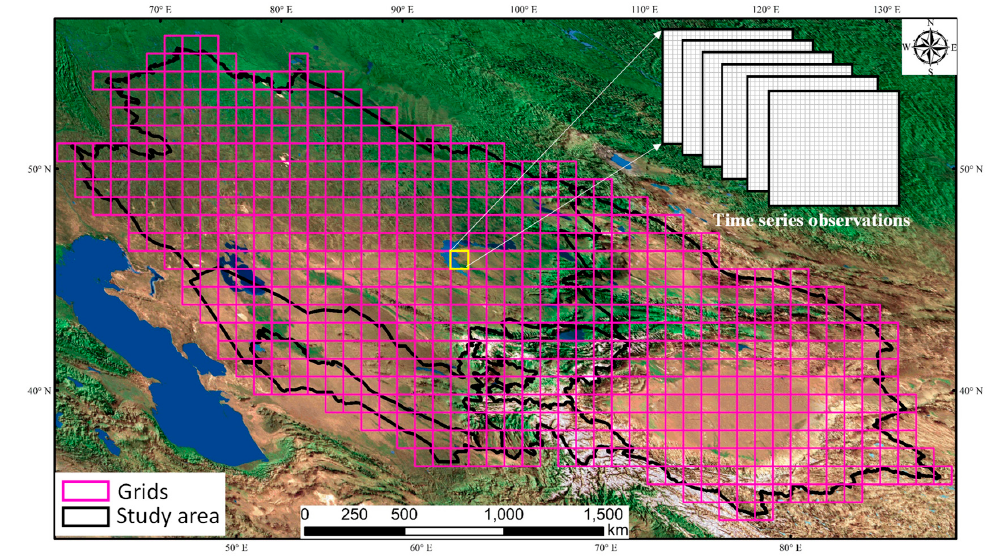
Figure 3. The grid distribution of the study area.